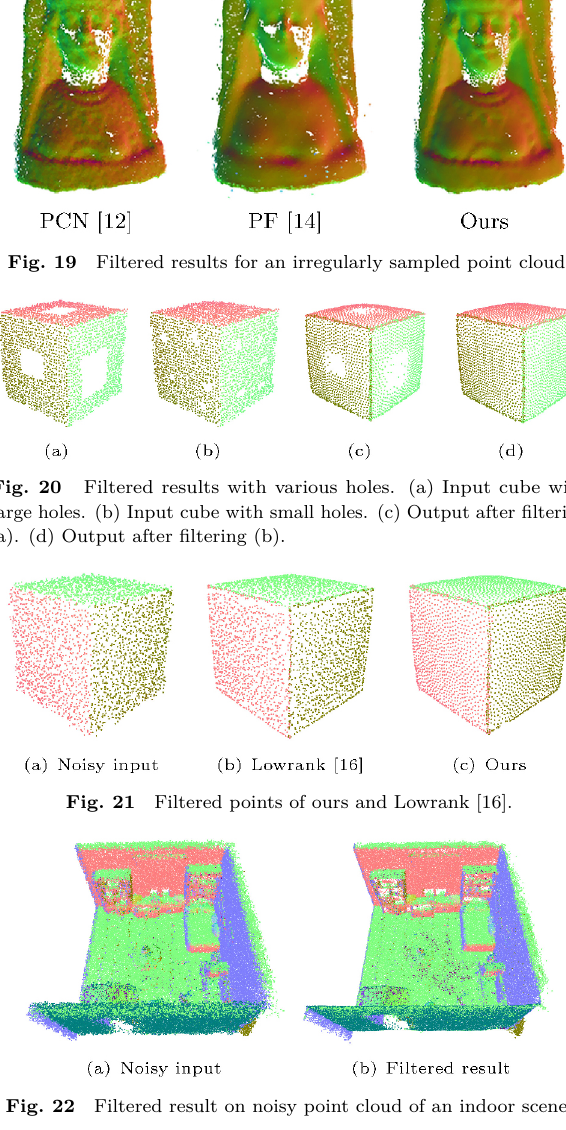
Fig. 11, taking 28 s.